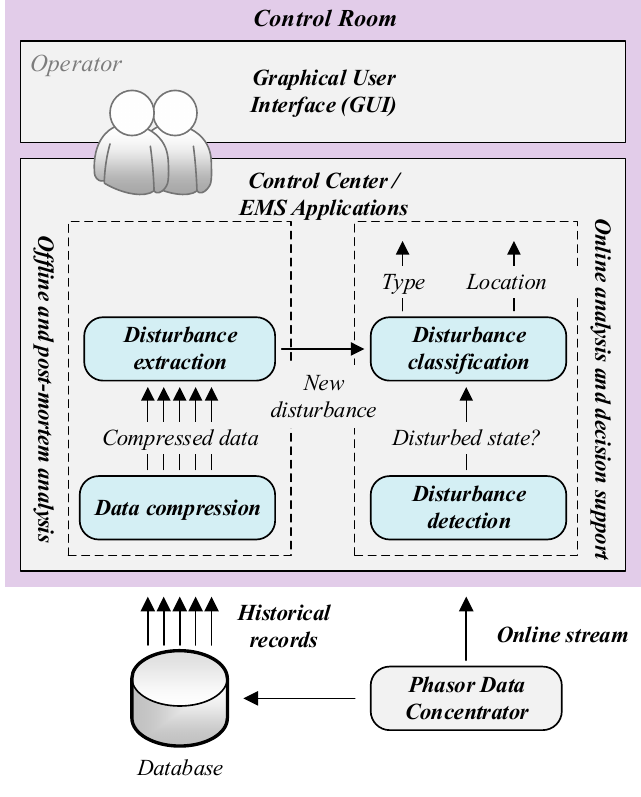
ffl ine synchrophasor based analysis